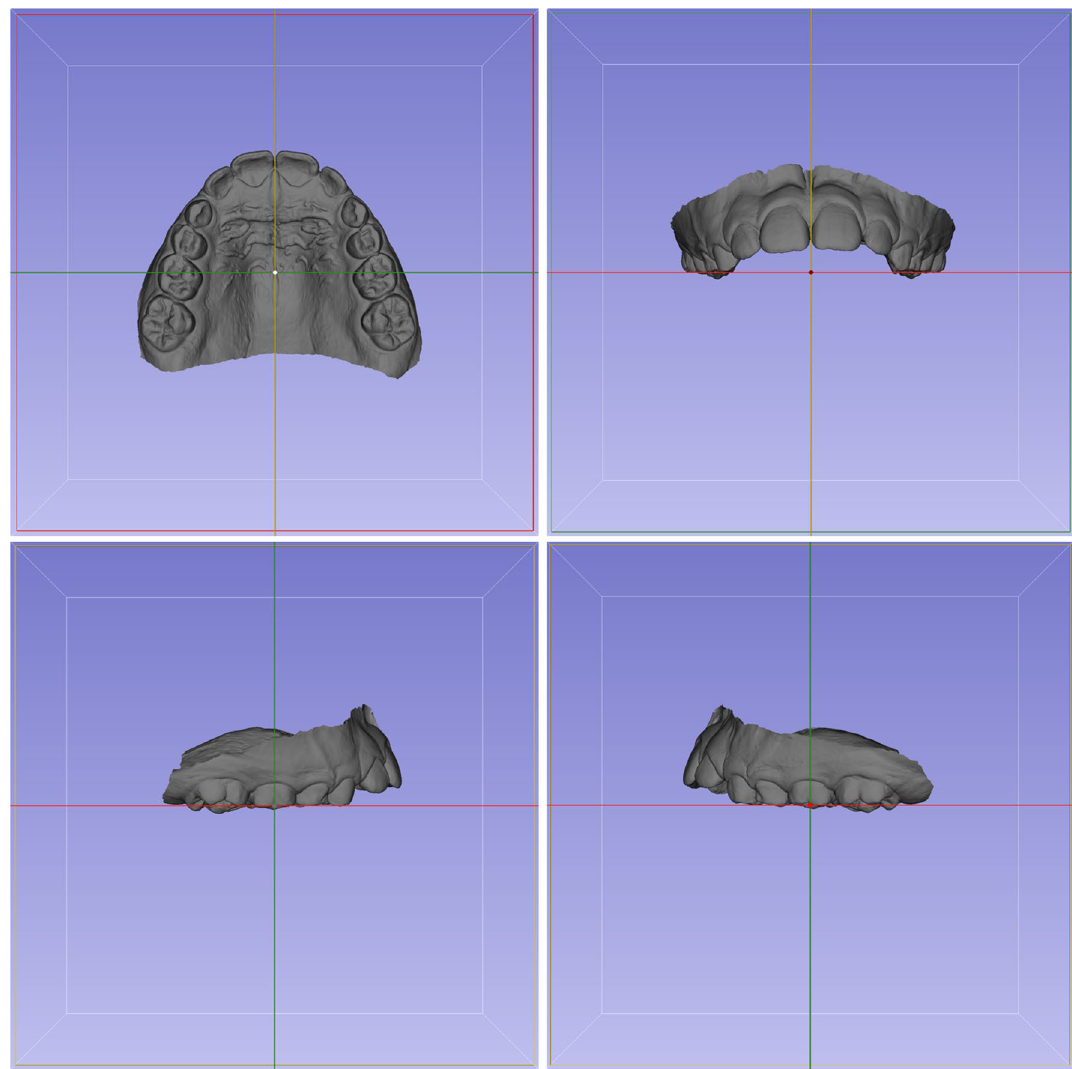
Figure 2. Study’s methodology. 3D Orientation of the T1 digital dental model. Axial view (upper left): the midpalatal raphe was centered with the sagittal plane and the center of the buccal surface of the right deciduous second molar was positioned coincidently with the coronal plane. Sagittal view (lower right and left): the occlusal plane (passing through the mesiobuccal cusp tips of the permanent and deciduous first molars) was leveled with the axial plane on the right and left sides. Coronal view (upper right): the cusp tips of the right and left deciduous first molars were leveled with the axial